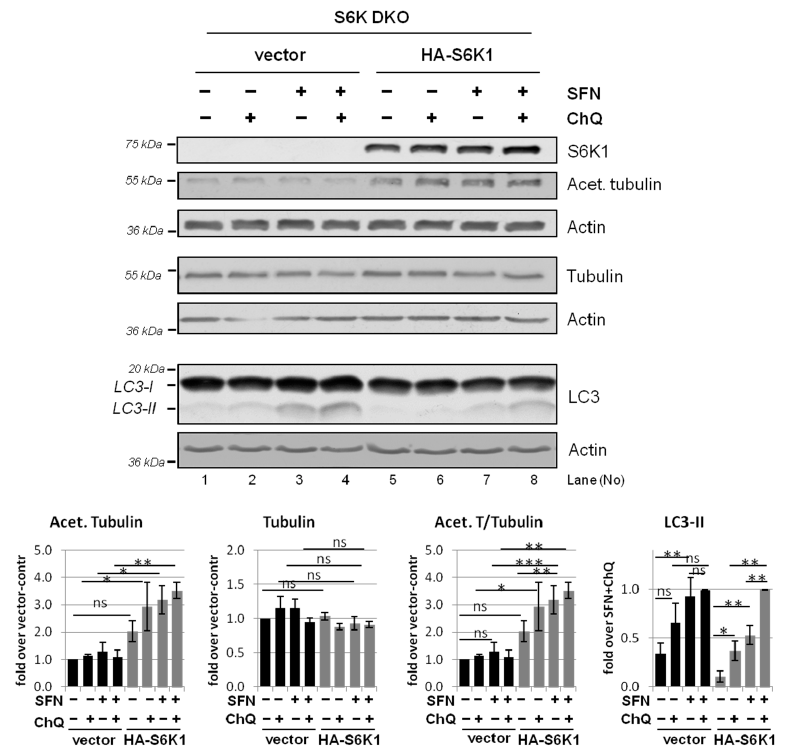
Figure 7. Overexpression of exogenous S6K1 restores tubulin acetylation and LC3-II degradation in S6K DKO MEF exposed to SFN. S6K DKO MEF were transfected with a plasmid coding for HA-S6K1 or a control vector, and exposed to 20 µM SFN or DMSO (control) for 3 h. The lysosomal inhibitor chloroquine (ChQ; 10 µM) was added for the last 2 h of treatment, as indicated. The S6K1, acetylated tubulin, total α -tubulin, and LC3 levels were evaluated by western blotting. The blots